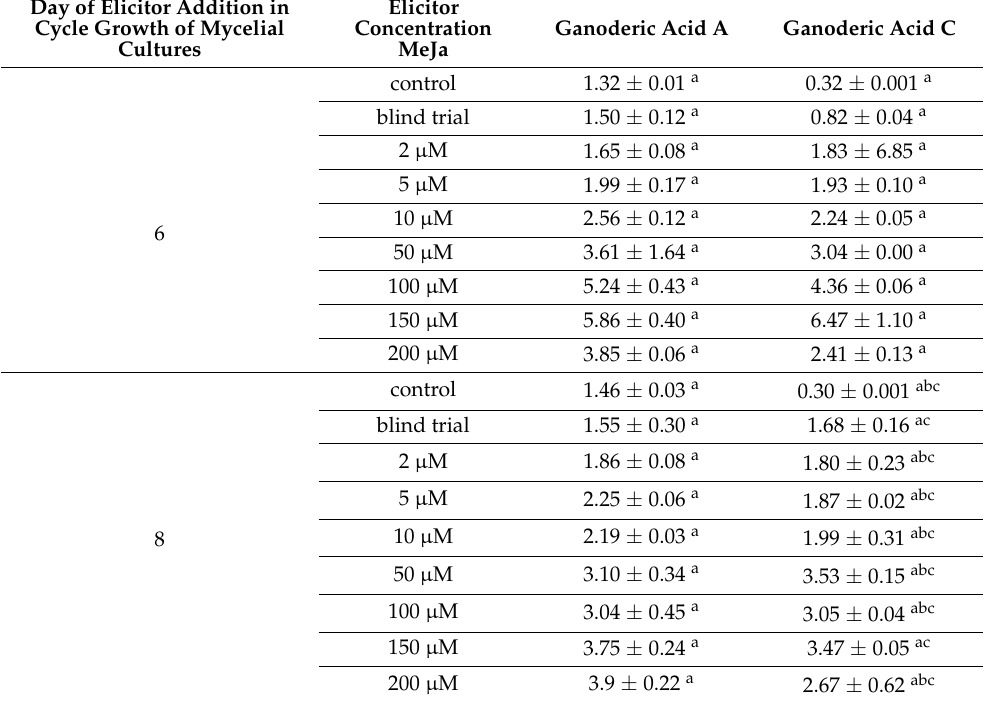
Table 1. Cont. Day of Elicitor Addition in Cycle Growth of